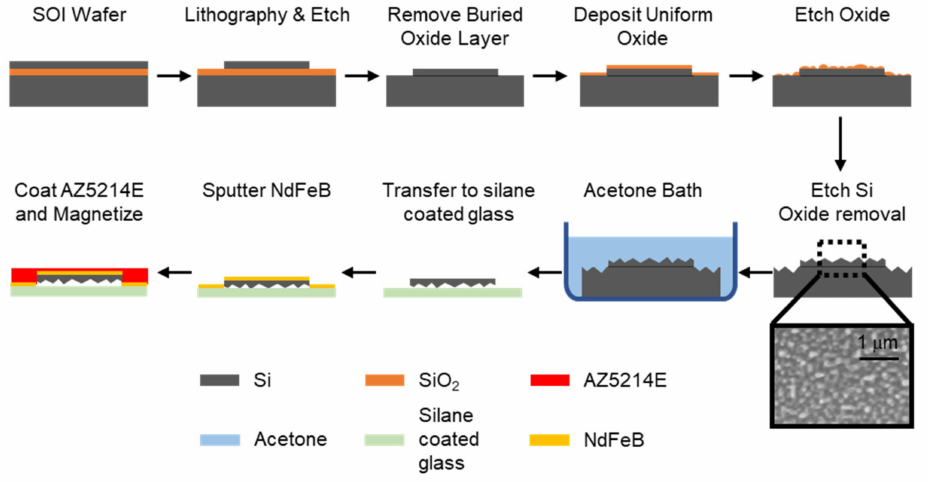
Figure 3. Fabrication of magnetized nanostructured black silicon